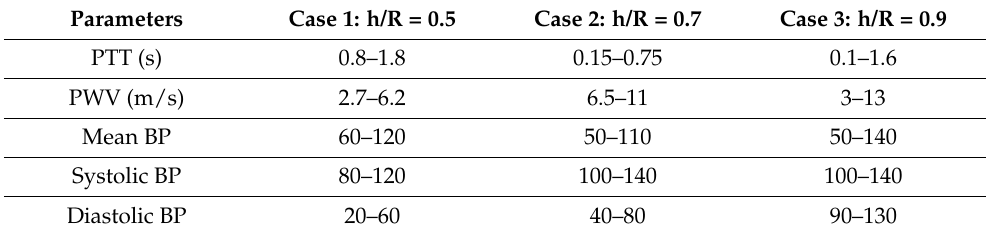
Table 5. Summary of estimated PTT, PWV and mean BP in the three studied cases.